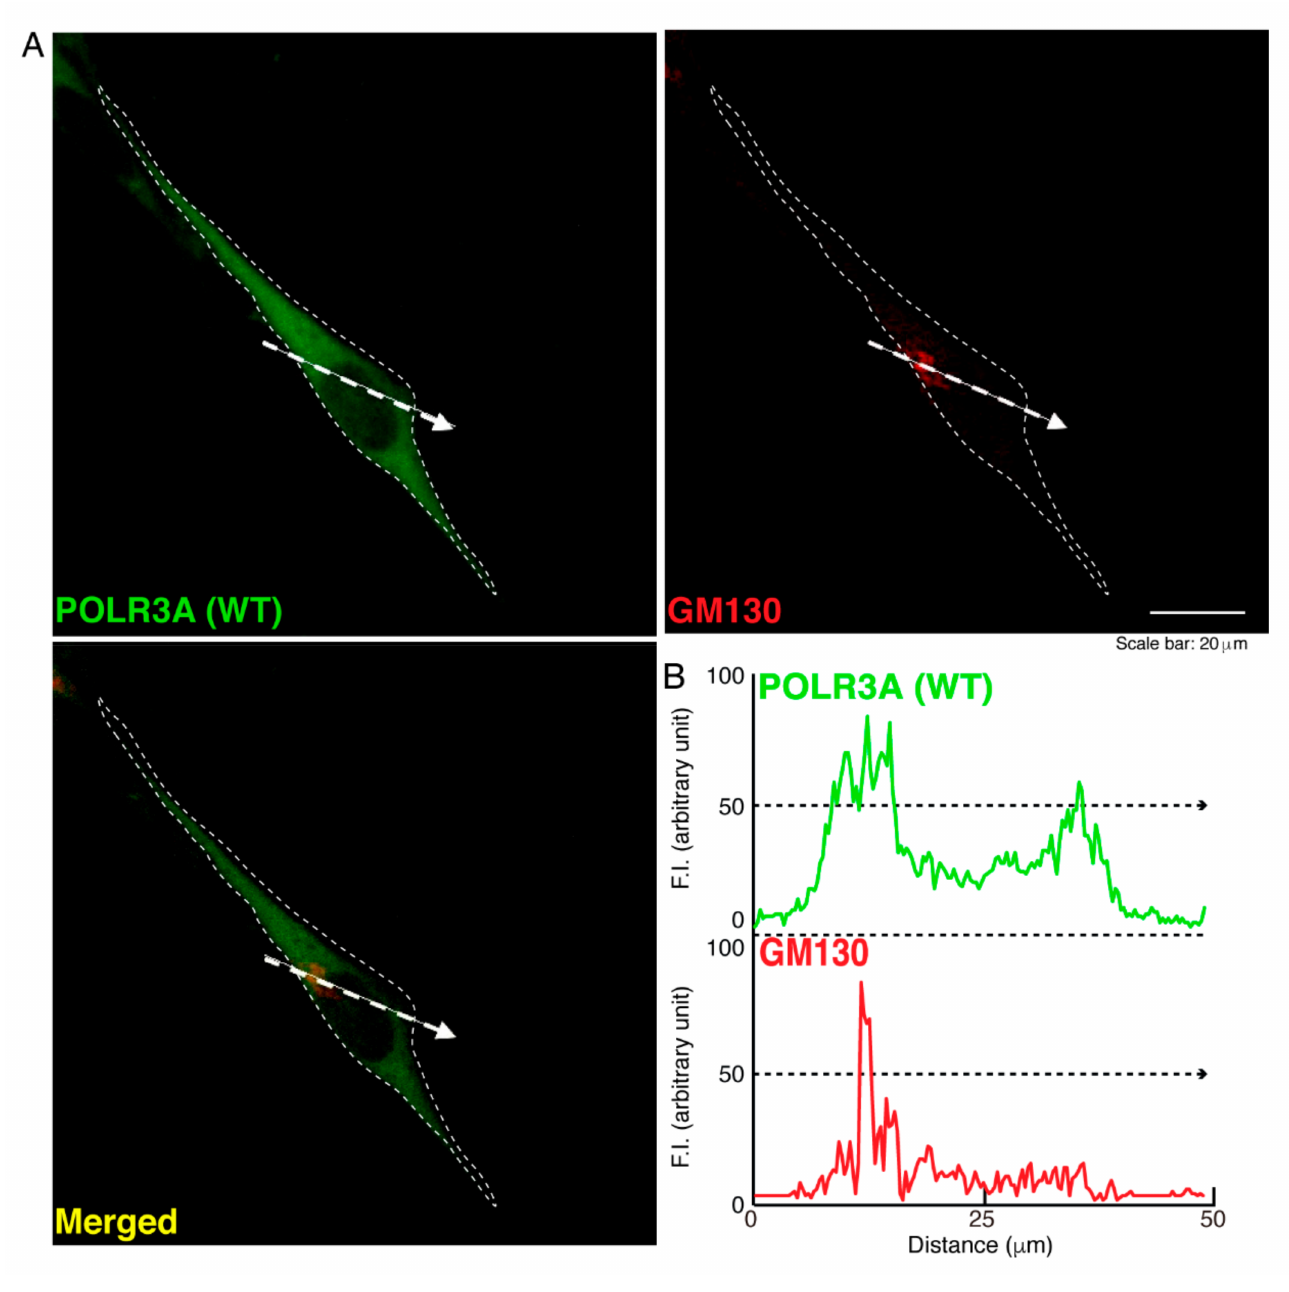
Figure 4. The wild type POLR3A proteins are not co-localized with the Golgi body in cells. ( A , B ) FBD − 102b cells were transfected with the plasmid encoding the wild type (WT) POLR3A (green) and stained using an antibody against the GM130 antigen (red). Scan plots were performed along the white dotted lines in the direction of the arrows in the color images (green and red as well as merged images). Graphs showing the fluorescence intensities (arbitrary units) along the white dotted lines in the direction of the arrows can be seen in the right bottom panels (black dotted